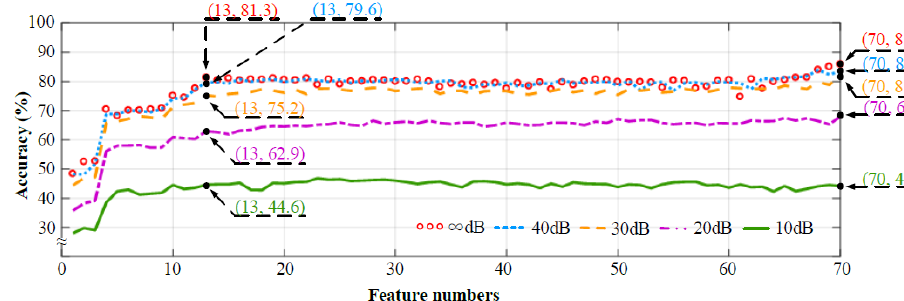
Figure 13. Accuracy curves of the HHT–CFS.